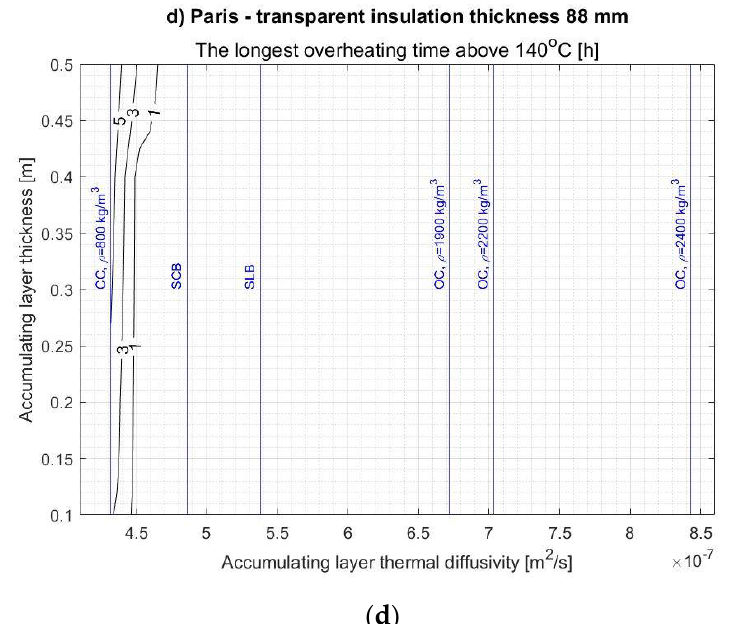
Figure A8. Contour graphs characterizing the SW basic parameters in a function of AL thermal diffusivity and thickness for the whole heating season: ( a ) the heat balance of the SW’s unit area, ( b ) the heating time, ( c ) the mean time lag of the maximum temperature on the absorber and SW’s internal surface during the day, ( d ) the longest overheating time above 140 °C in the TI. TI thickness: 88 mm. Location: Paris.